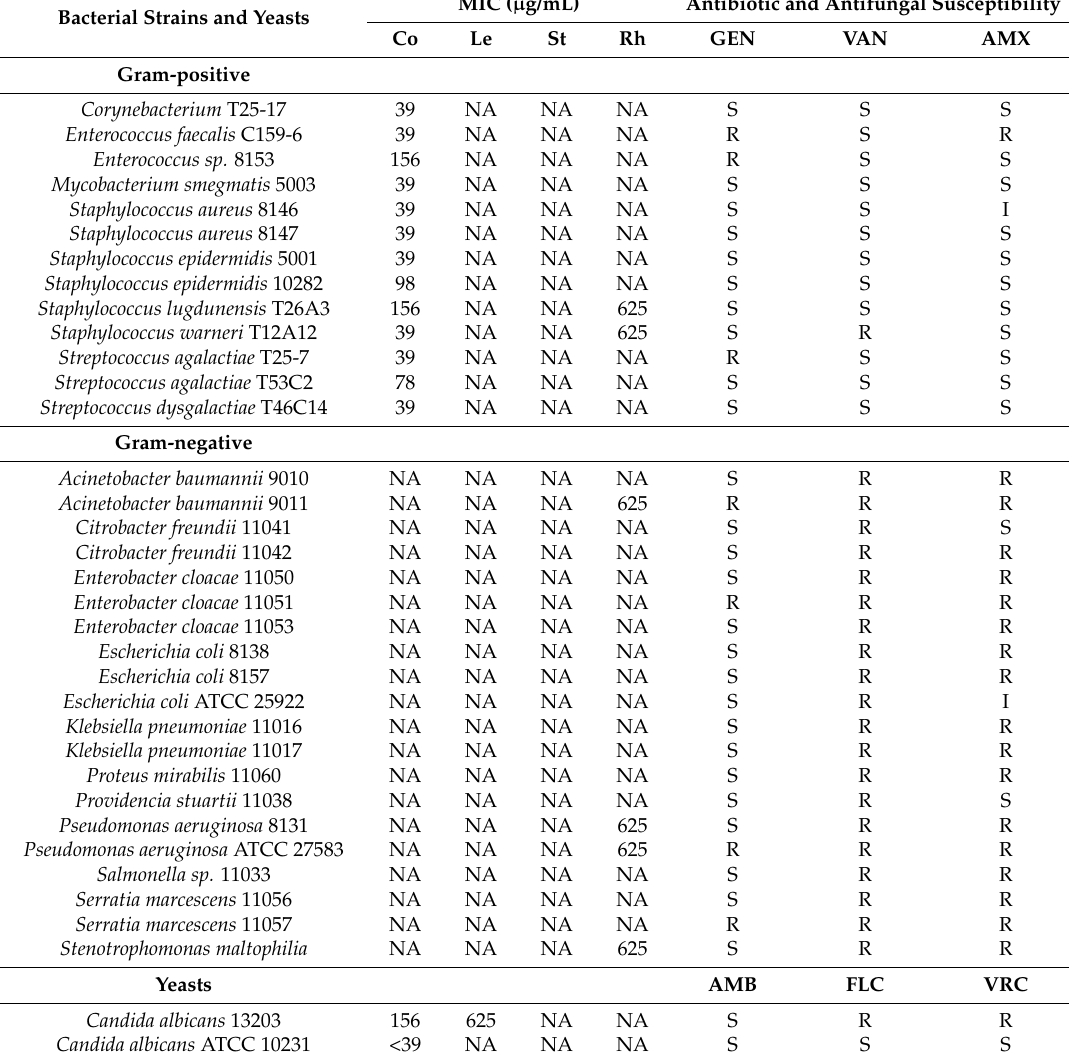
Table 1. MIC (in µ g/mL) of hop hydro-ethanolic crude extracts (Co: cones, Le: leaves, St: stems, Rh: rhizomes) against some human pathogenic bacteria with their corresponding antibiotic susceptibility (S: susceptible I: intermediate, R: